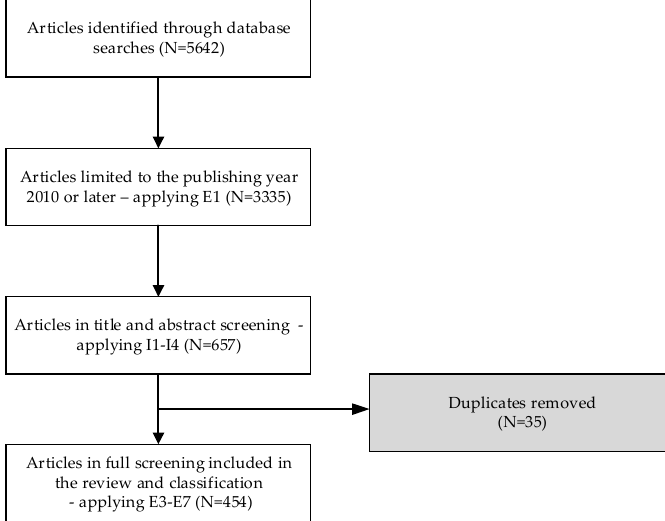
Figure 4. Flow diagram of the database searches and article screening process. Table 4. Steps in screening and selection of the relevant literature.